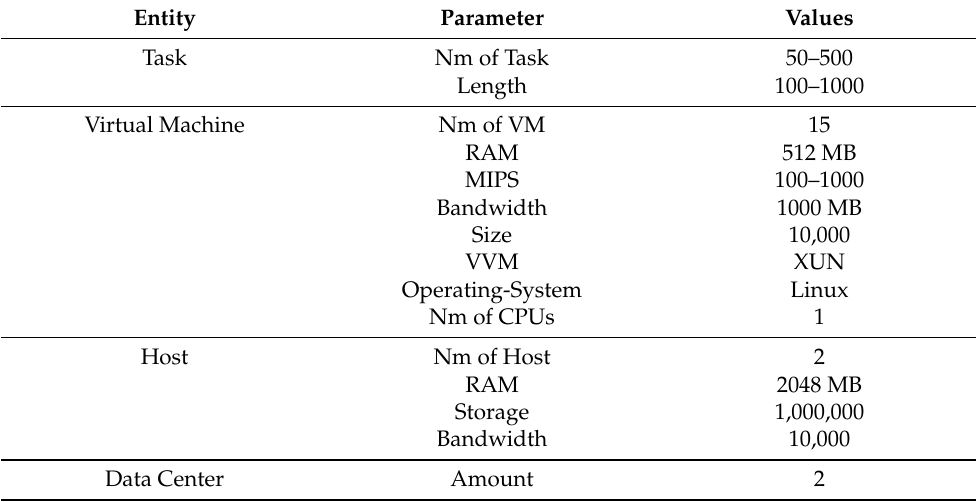
Table 4. Environment 1